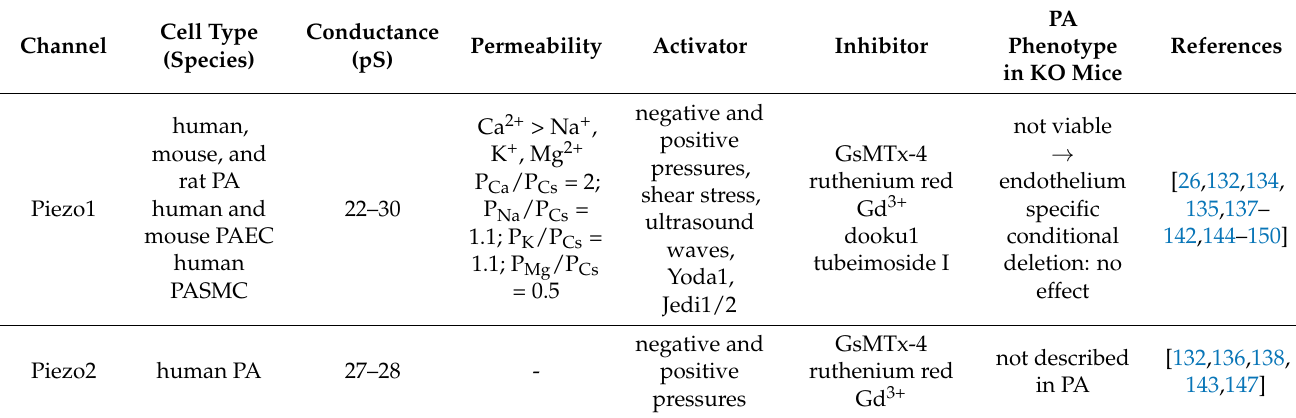
Table 2. Biophysical properties of Piezo channels in pulmonary arterial vascular